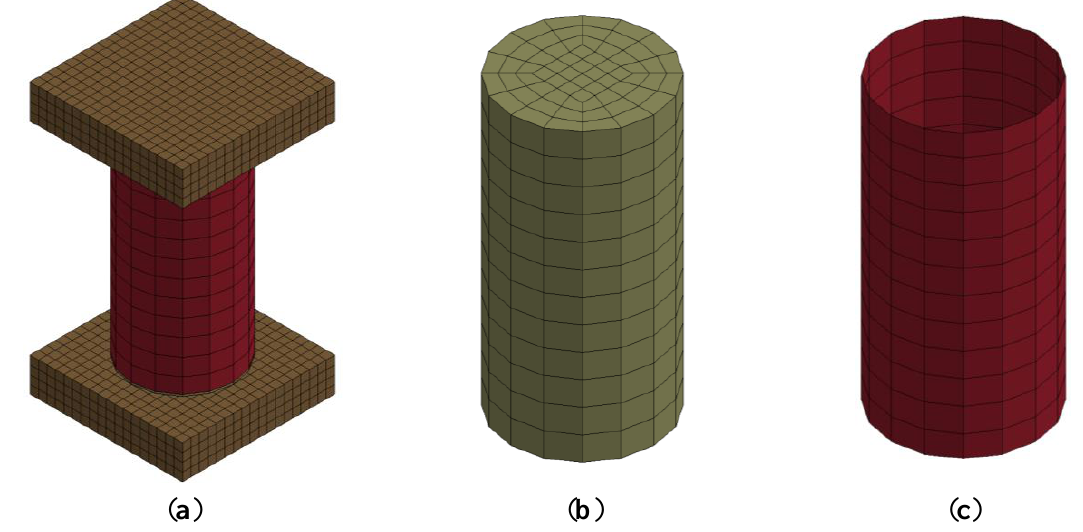
Figure 1. Finite element model components: ( a ) 3-D view; ( b ) concrete cylinder; and ( c ) FRP